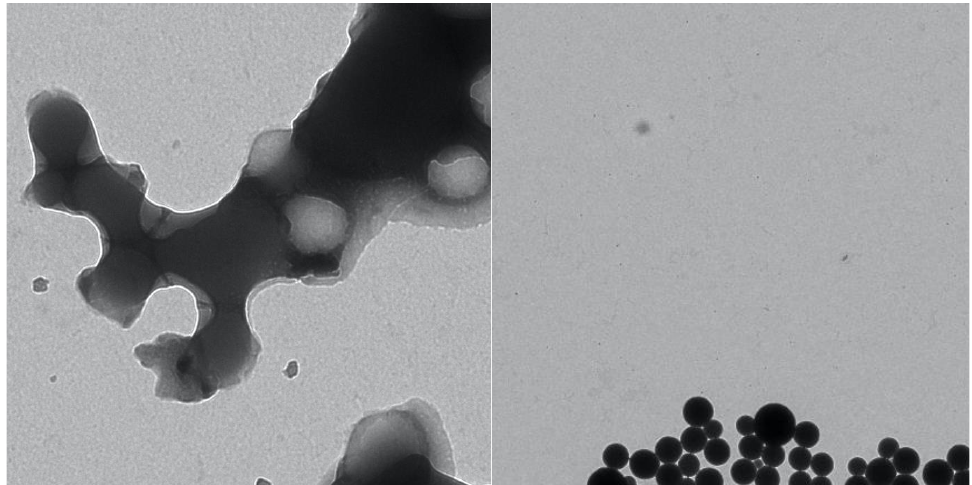
Figure 1. Transmission electron microscopy of PLG nanoparticles. Aqueous nanoparticle suspension was placed on a copper grid and allowed to dry, then examined with a transmission electron microscope. Images are representative of typical PLG nanoparticles.